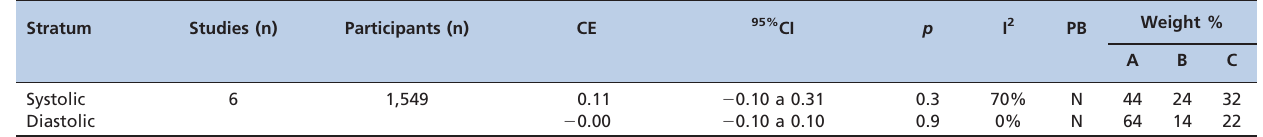
Table 2 - Analysis of blood pressure outcome .